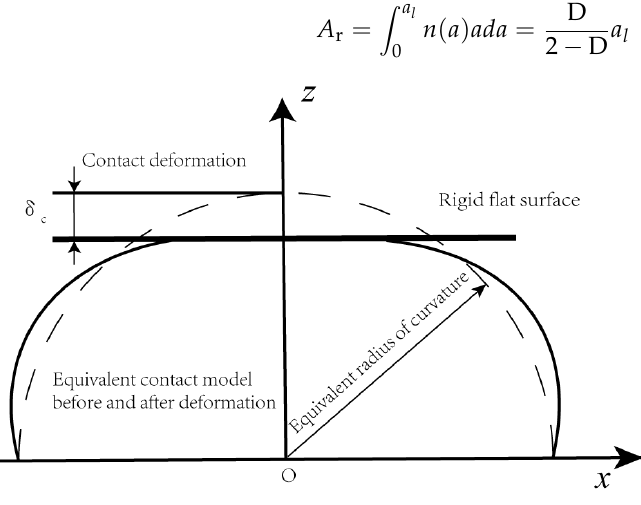
( a ) Contact model of the rigid plane and single asperity.